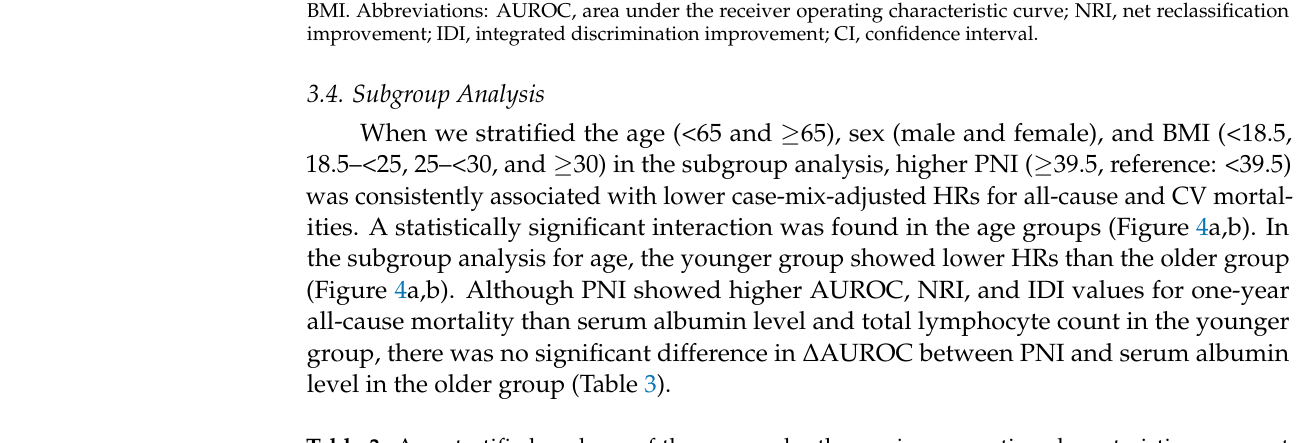
Table 3. Age-stratified analyses of the area under the receiver operating characteristic curve, net reclassification improvement, and integrated discrimination improvement for one-year all-cause mortality by including the prognostic nutritional index, serum albumin level, or total lymphocyte count in the case-mix-adjusted logistic regression